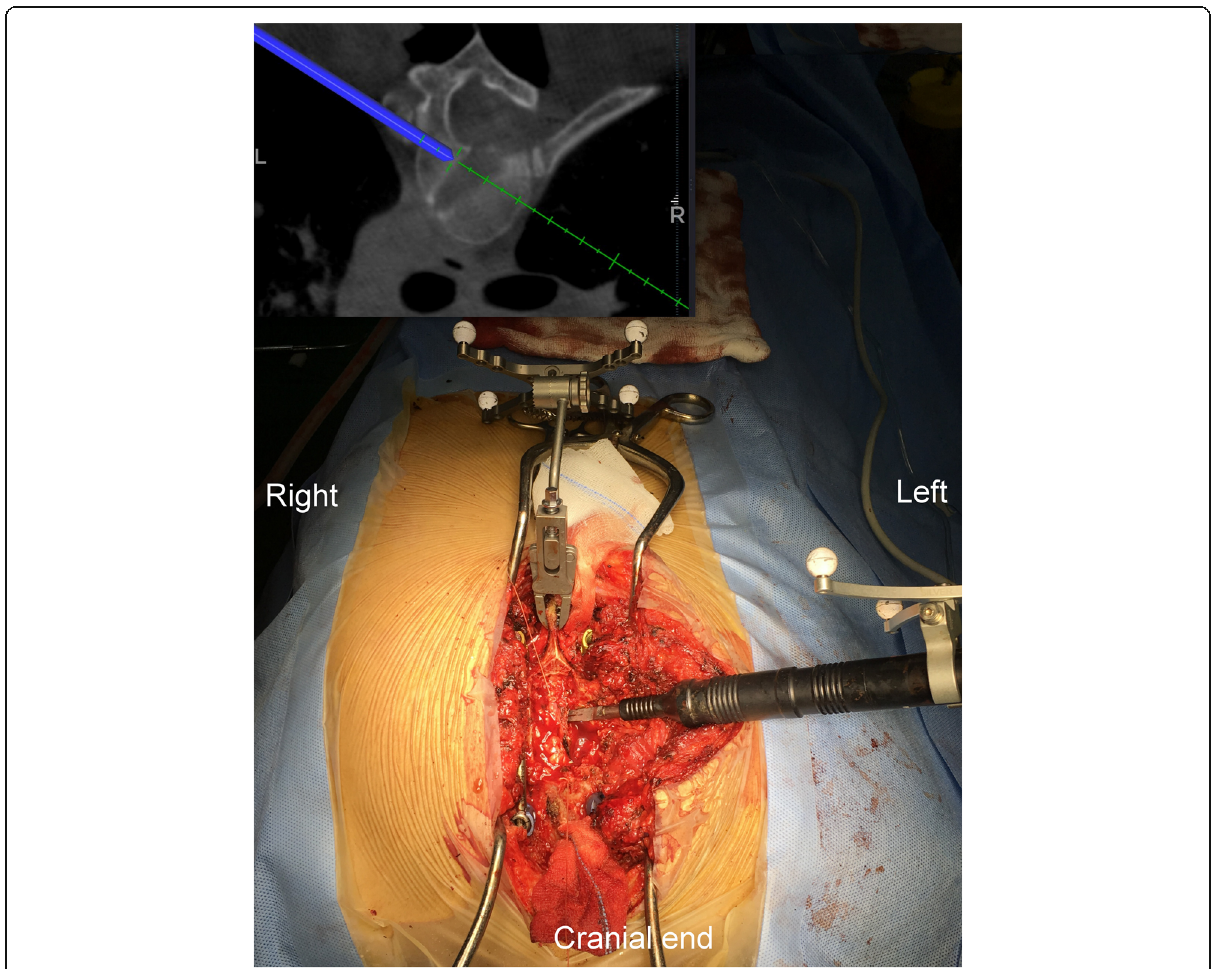
Fig. 3 Horizontal cut with UBS for creating trough space by cutting out the bone block. Virtual image showing navigated UBS is being used to cut out the bone block ventral to the cord and thin slab